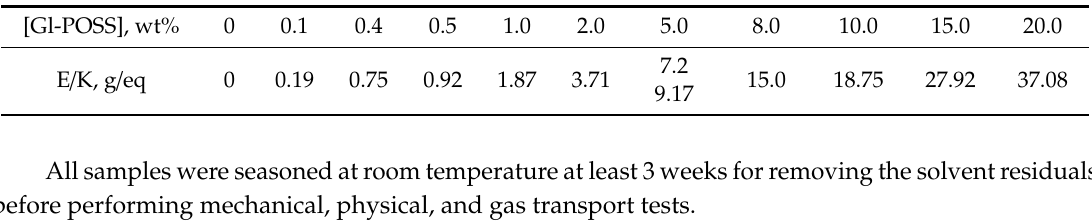
Table 1. The ratio of [~ О − К + ] and [ ] groups (E/K).